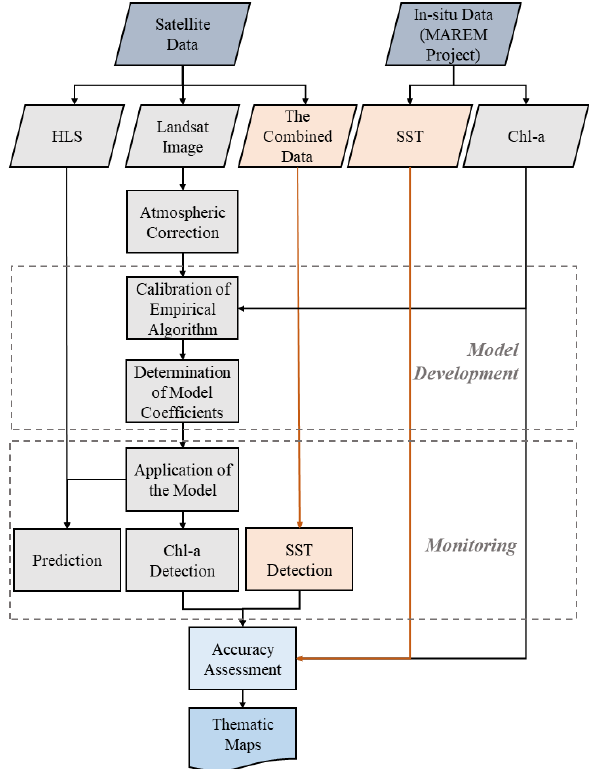
Figure 3. The flow chart of the methodology.